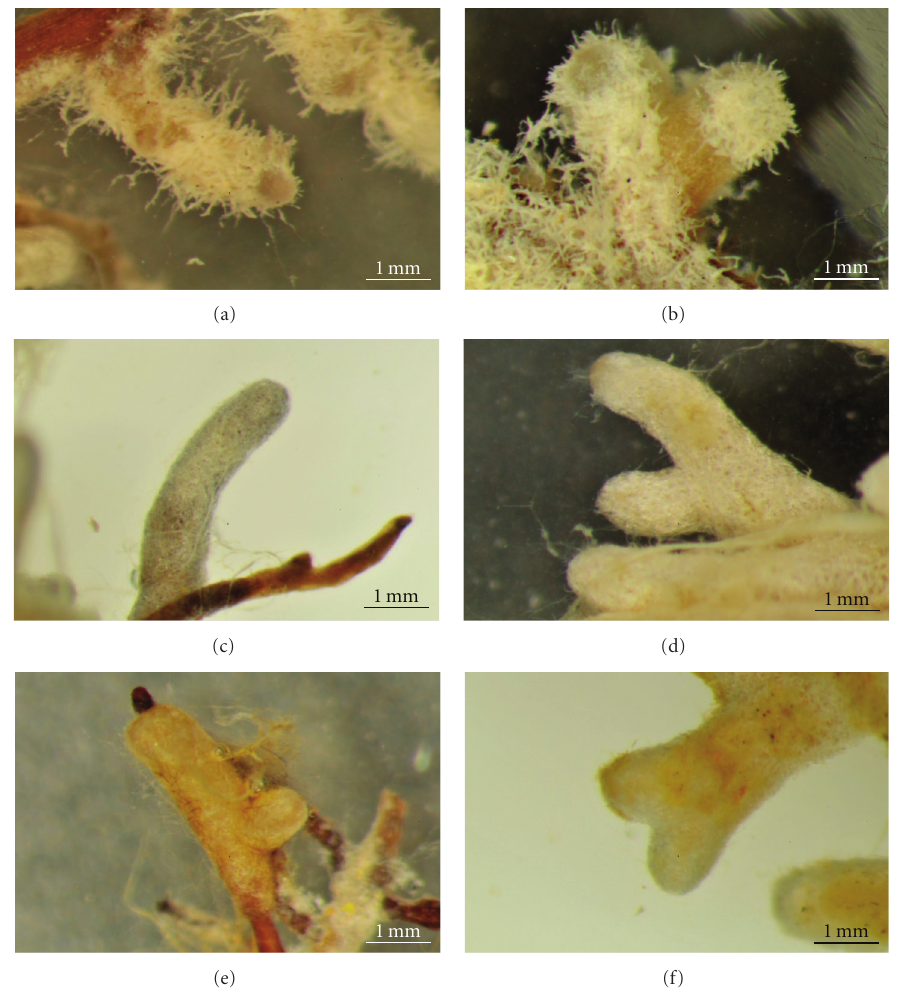
Figure 5: Photographed (45x) ECM morphotypes sampled from American chestnut ( C. dentata ) and P. virginiana root tips from pine plots. Panels display the following that were matched to vouchered GenBank sequences: (a) Thelephora sp. on C. dentata , (b) Thelephora sp. on P. virginiana , (c) Scleroderma sp. on C. dentata , (d) Scleroderma sp. on P. virginiana , (e) Pisolithus sp. on C. dentata , and (f) Pisolithus sp. on P. virginiana . Bar =